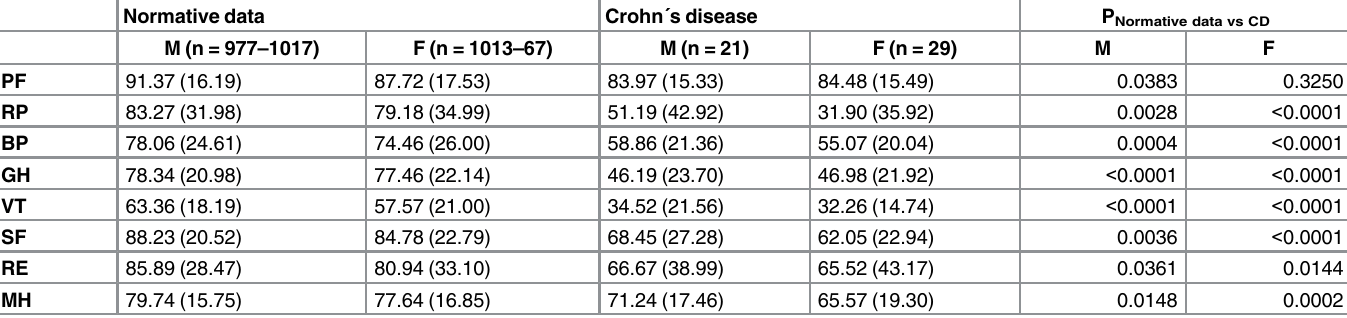
Table 5. Mean SF-36 scale scores. Age-adjusted Normative Data from the Norwegian Population compared with patients with CD on inclusion. Normative data